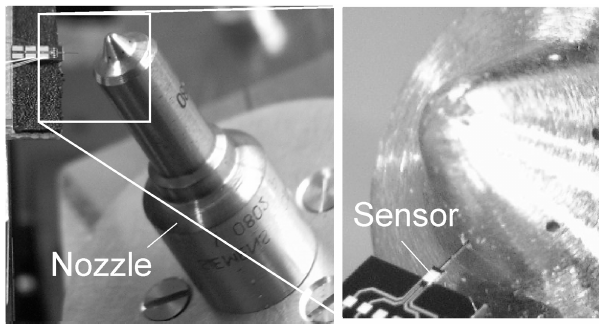
Figure 39. Detailed view of Si-cantilever microprobe, bonding wires, and flex tape for electrical connection [13].